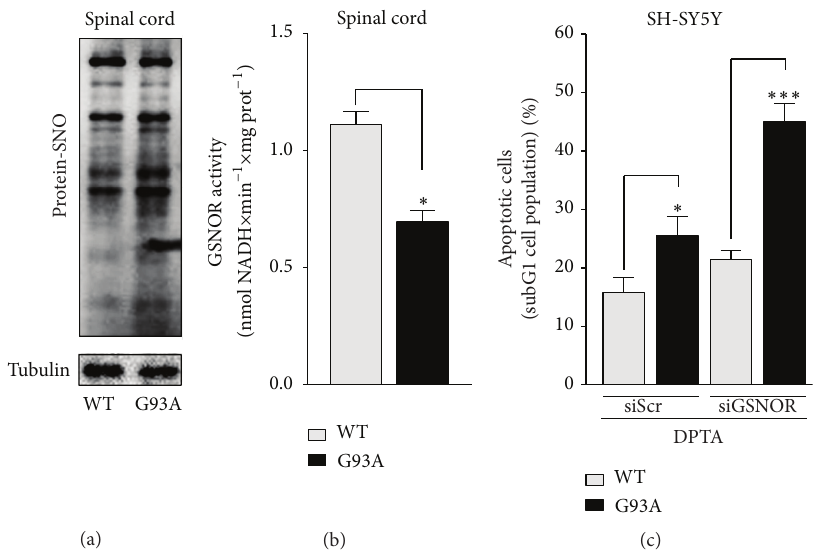
Figure 6: Characterization and sensitivity of G93A models to nitrosative stress. Biotin switch assay of total protein-SNOs (a) and analysis of GSNOR activity (b) performed on spinal cord lysates of WT and G93A-SOD1 expressing mice (G93A). (c) Cytofluorimetric analyses of apoptosis upon propidium iodide staining performed on parental SH-SY5Y cells (WT) and G93A-SOD1 mutants (G93A) transfected or not with siRNA against GSNOR (siGSNOR) and treated for 24 h with 400 𝜇 M DPTA. Western blots shown are representative of at least 𝑛 = 3 independent experiments that gave similar results. Tubulin was selected as loading control. Graphs shown represent the mean of data ± SD of 𝑛 = 3 independent experiments, ∗ 𝑃 < 0.05 and ∗∗∗ 𝑃 < 0.001 ; n.s.: not